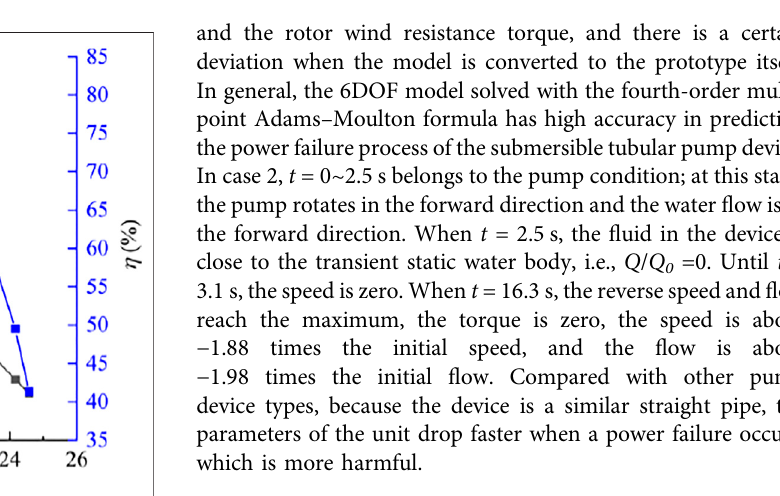
Frontiers in Energy Research |